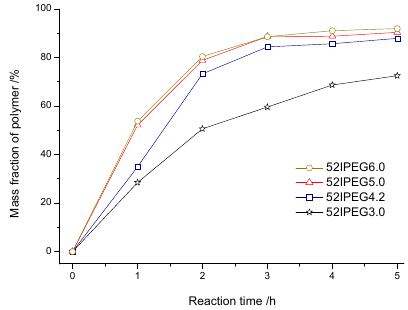
Figure 3. The mass fraction of polymers produced in 52IPEGs over time.